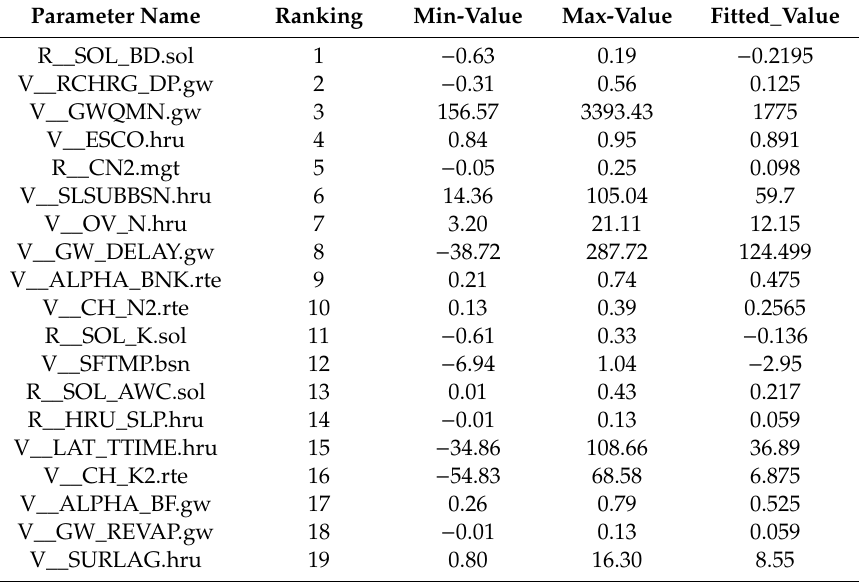
Table 3. Nineteen parameters used for model calibration.